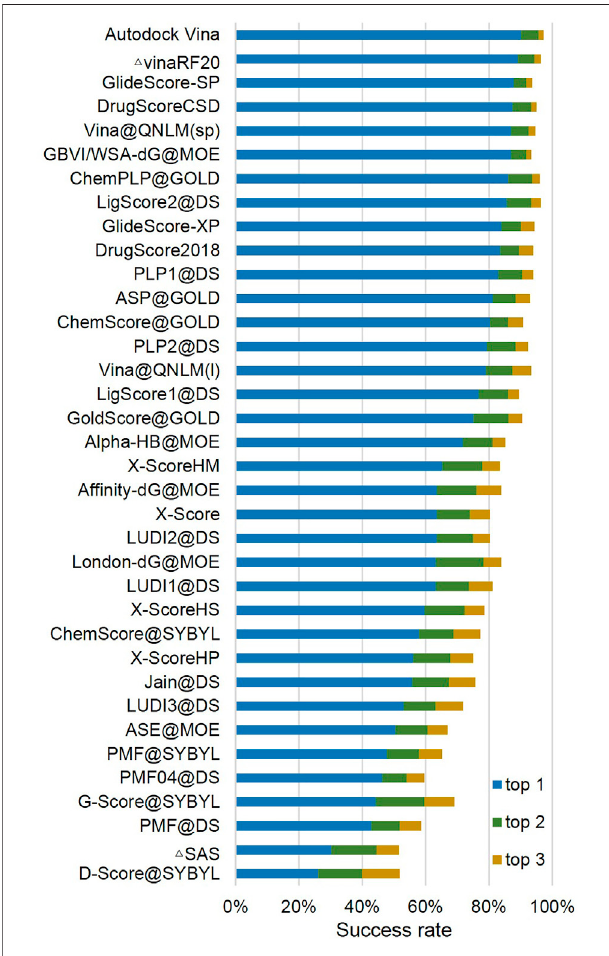
FIGURE 9 | Docking power of top 1 (1%), top 2 (5%), and top 3 (10%) success rates of Vina@QNLM in single-point (sp) and local (l) modes (blue, green, and orange bars), compared to the methods evaluated in CASF-2016 and recalculated.